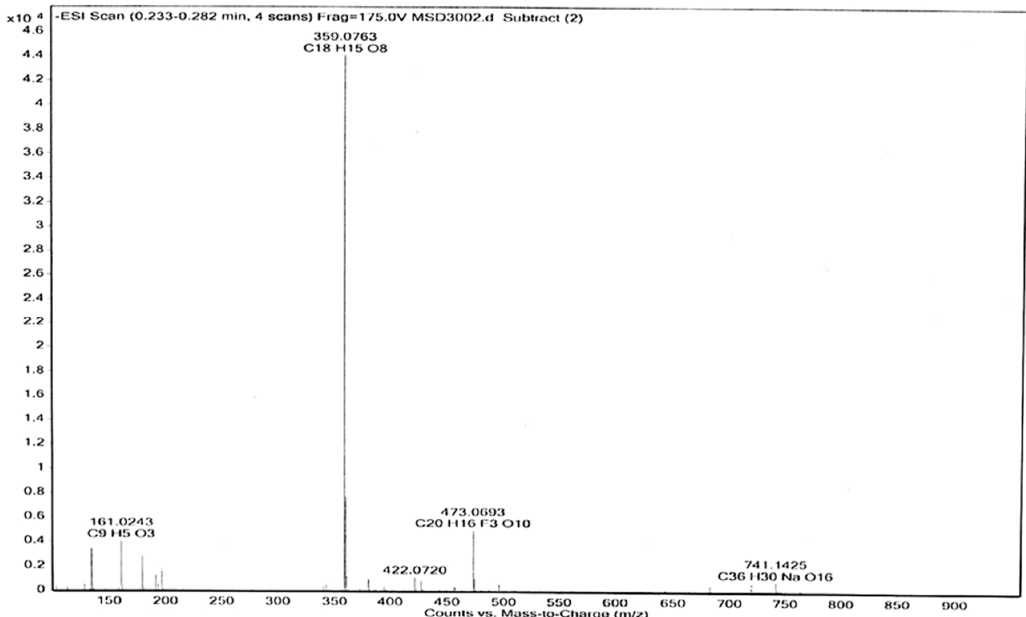
Figure 3. Electrospray ionization (ESI-MS) base peak chromatogram of a rosmarinic acid (RA)-enriched methanolic extract of S. khuzistanica cell cultures (SKE) in negative ion mode. Mass spectra were detected in the range of m / z 100–1000. A molecular weight of 359 was assigned to [M − H] − , and 741 to [2M − 2H + Na] − of RA.